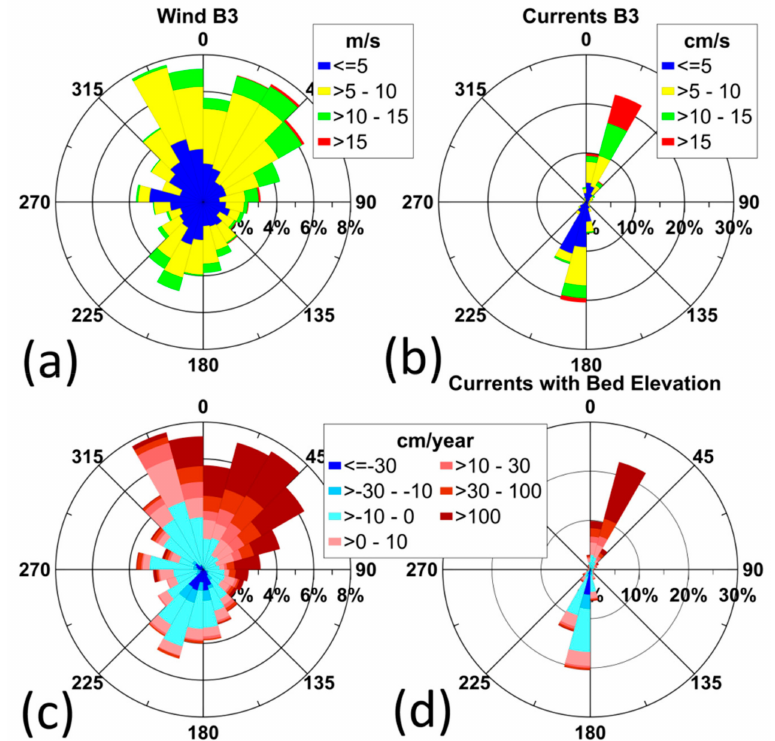
Figure 8. ( a ) Wind and ( b ) depth-averaged currents roses in 2014 for the point B3 showing their directions and speeds. Wind and currents are directed from the center of the rose; ( c ) wind rose together with sedimentation intensity at the point B3; ( d ) depth-averaged currents rose together with sedimentation intensity at the point